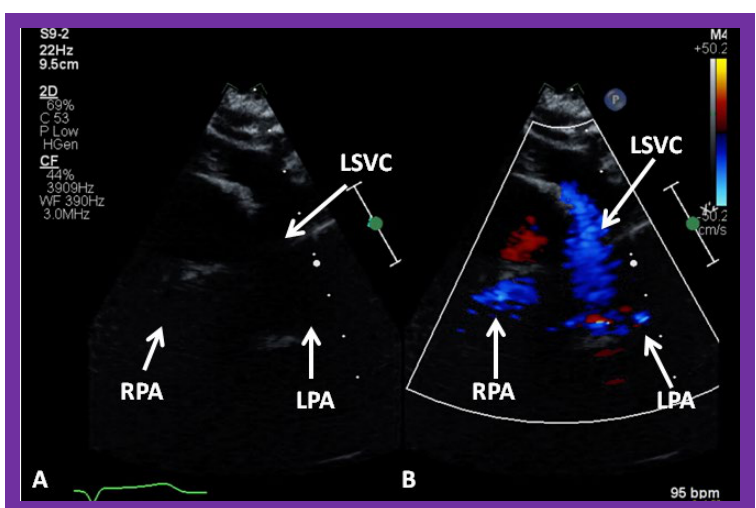
Figure 30. ( A , B ) Selected video frames from suprasternal notch view demonstrating left sided bidi- rectional Glenn shunt. In ( A ), the right (RPA) and left (LPA) pulmonary arteries are faintly seen by 2D. On color Doppler study, the visualization is slightly better ( B ). LSVC, left superior vena